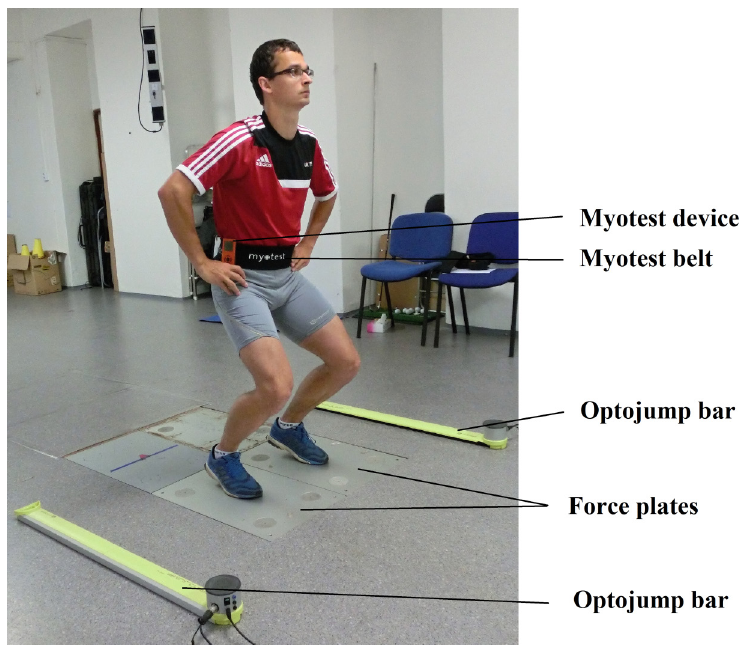
Figure 1. Laboratory measurement settings. Participants performed countermovement jumps standing on two force plates with their hands on the hips. Optojump bars were placed on both sides of force plates, and the Myotest was secured to the waist using the manufacturer’s